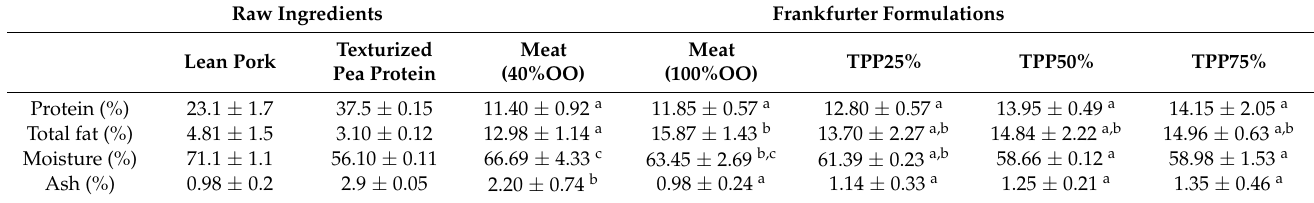
Table 3. Mean values (+SD) of proximate composition parameters for raw materials and frankfurter